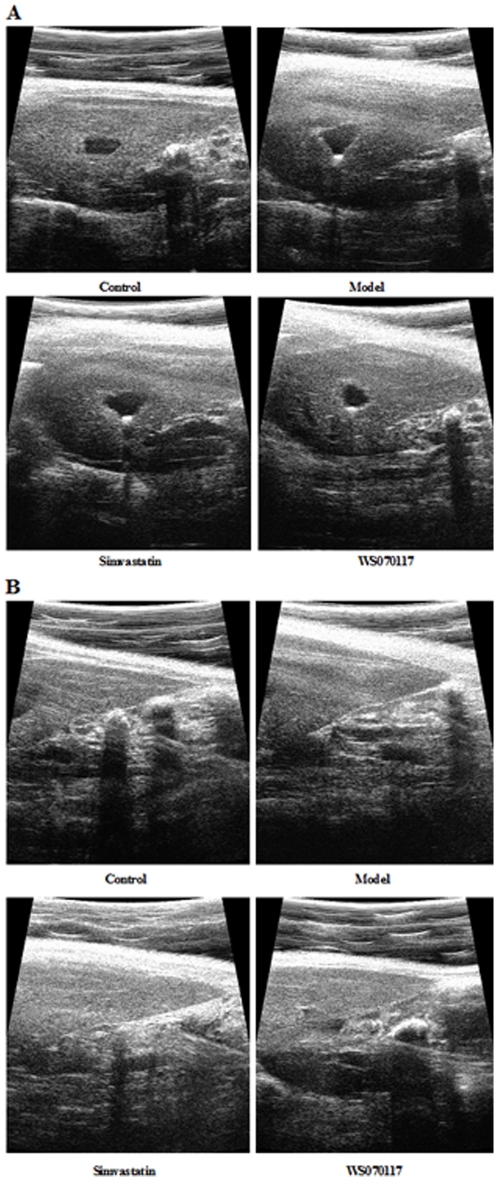
Various echogenicity in hamster liver tissue demonstrates that WS070117 prevents fat accumulation in the liver.(A) Images of pericholecystic space; (B) Images of liver edge.